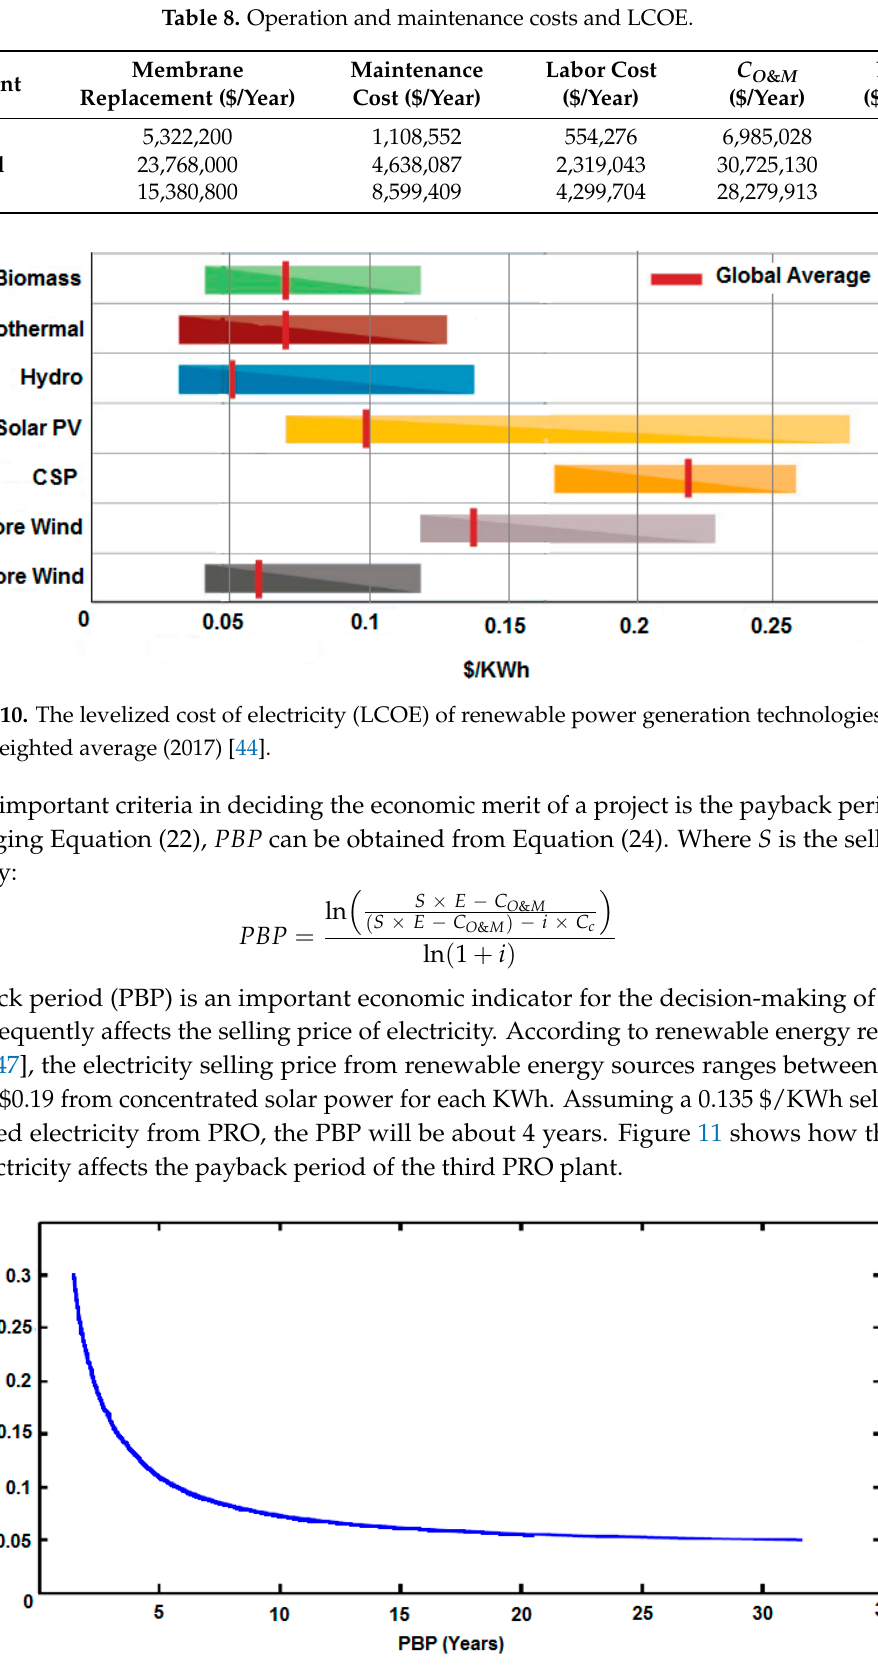
Table 8. Operation and maintenance costs and LCOE.